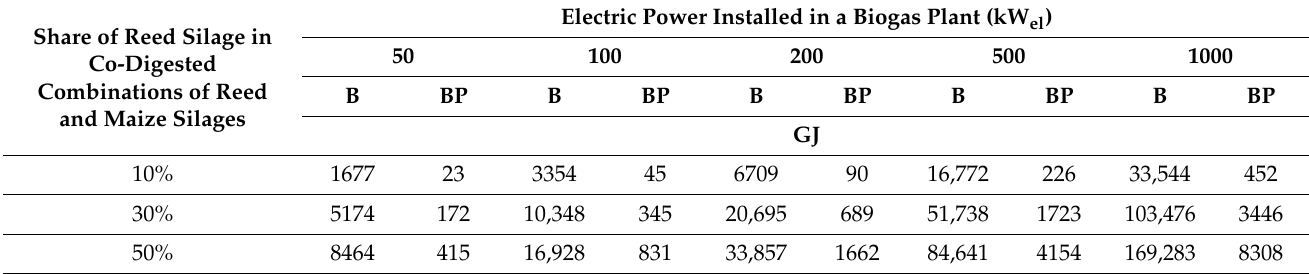
Table 5. Heat generation from reed direct incineration and biogas produced from reed.